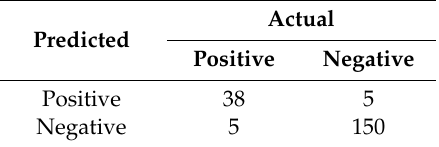
Table 9. Confusion matrix for model Van in an experiment.